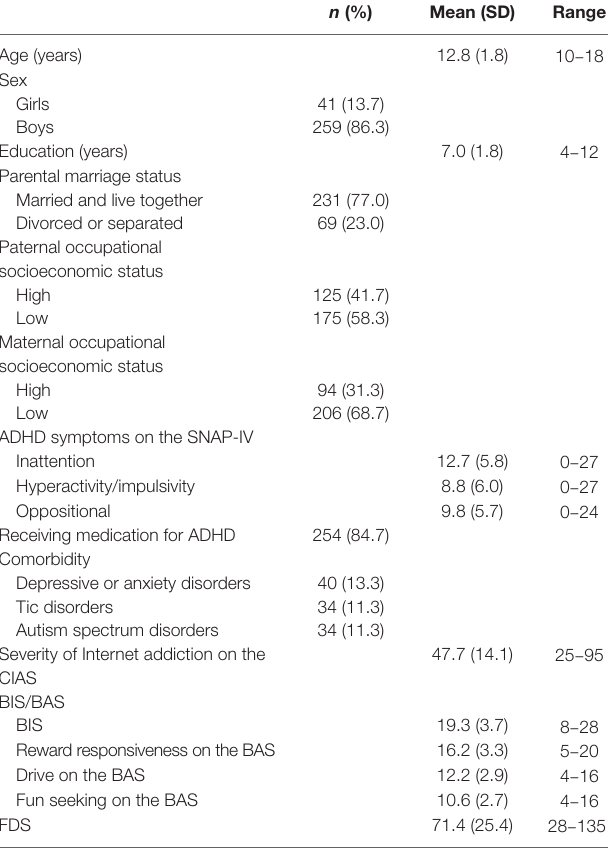
TABLE 1 | Sociodemographic and ADHD characteristics, comorbidities, internet addiction severity, and levels of BAS/BIS and FDS (N = 300).